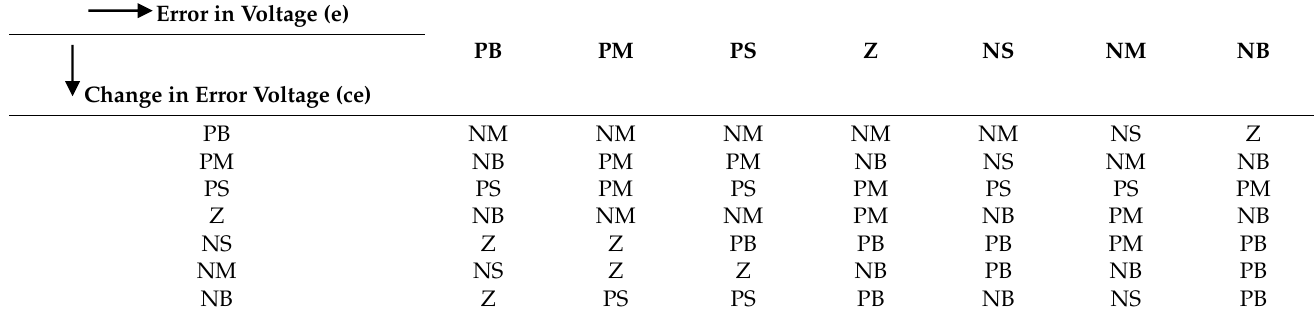
Table 1. Fuzzy rules for the proposed shunt active power filter (SAPF).